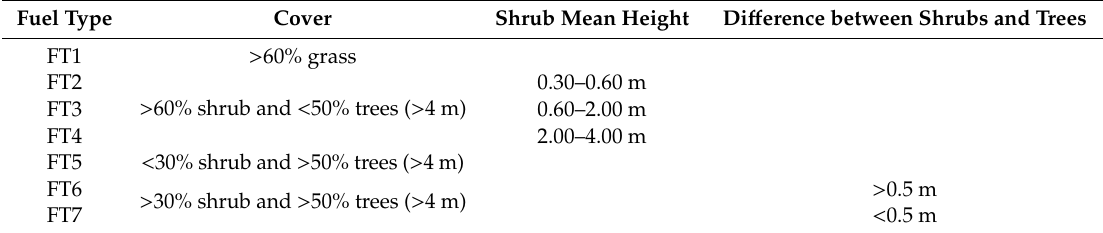
Table 1. Fuel types defined by Prometheus classification.